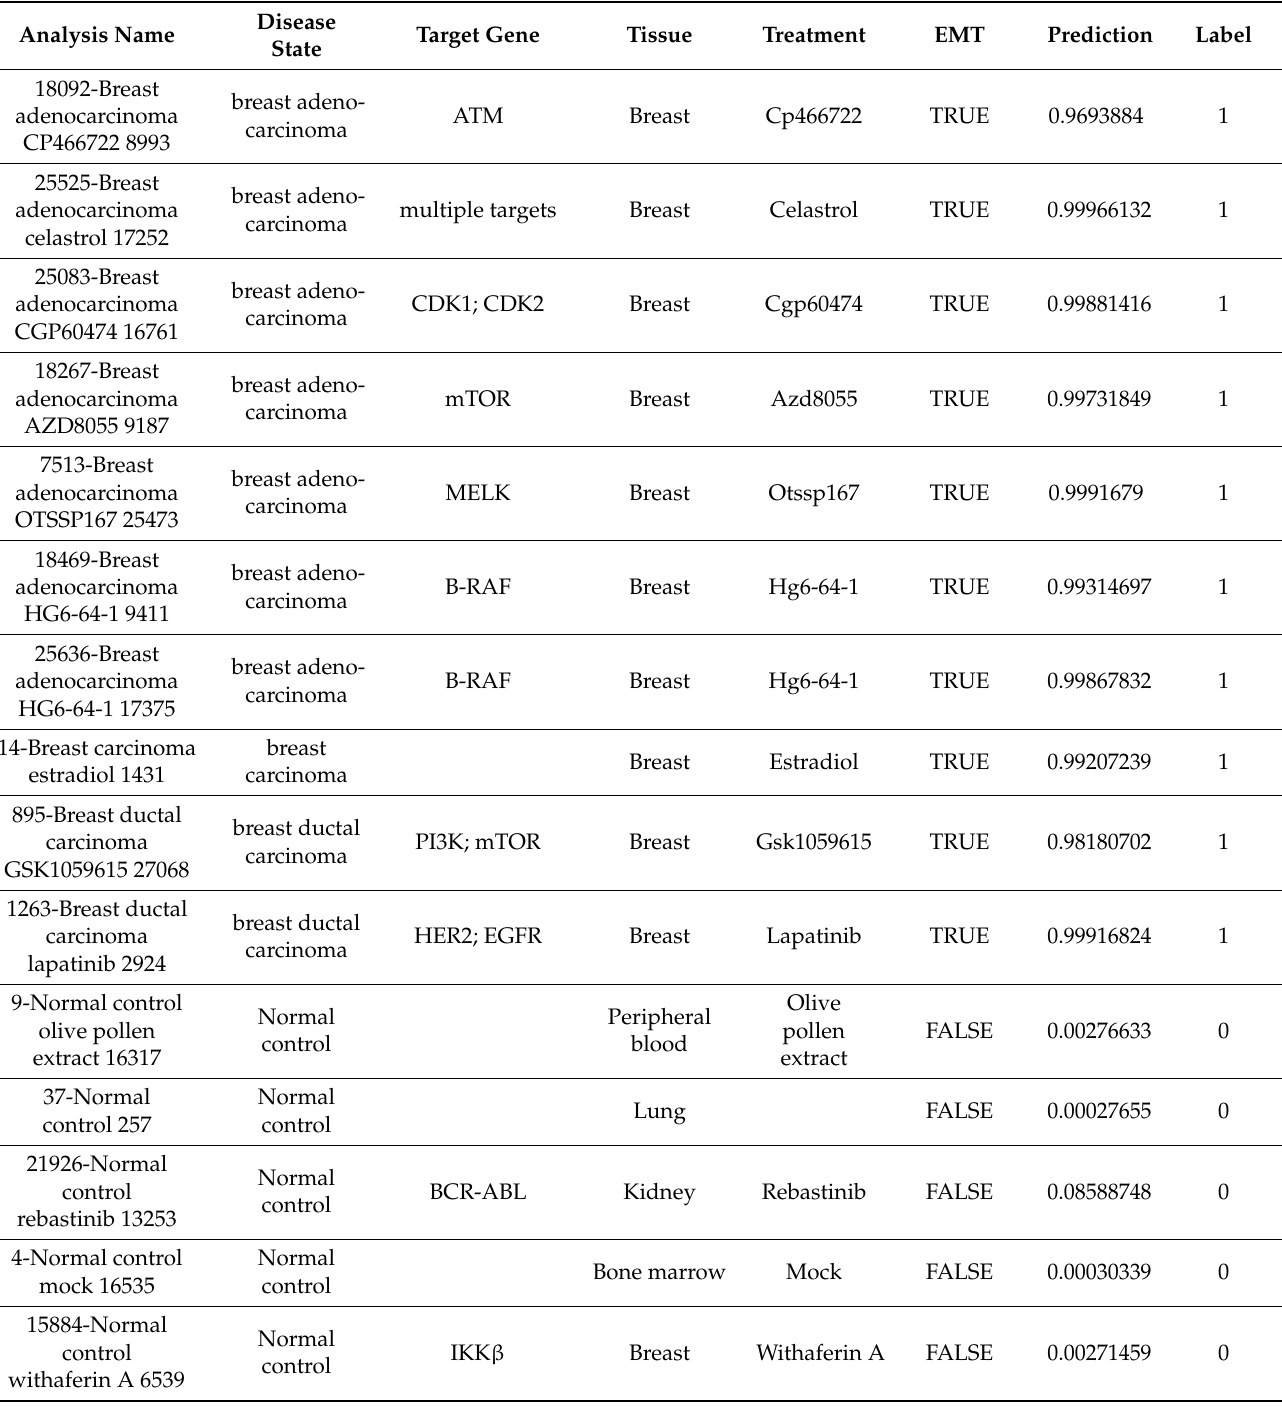
Table 2. Validation of the model